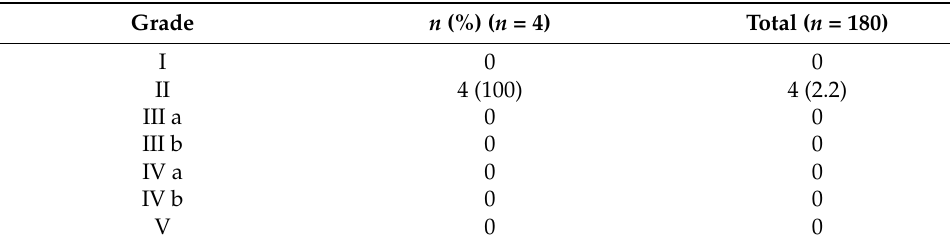
Table 5. Parental satisfaction evaluation.